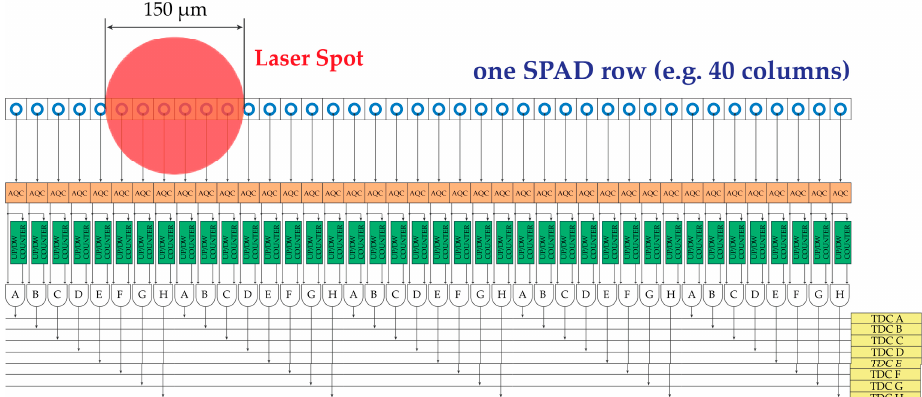
Figure 15. Example of one row of the SPAD array: by grouping columns together in N channels (e.g., N = 8, from A to H), only N TDCs are required per each row whatever number of actual col-